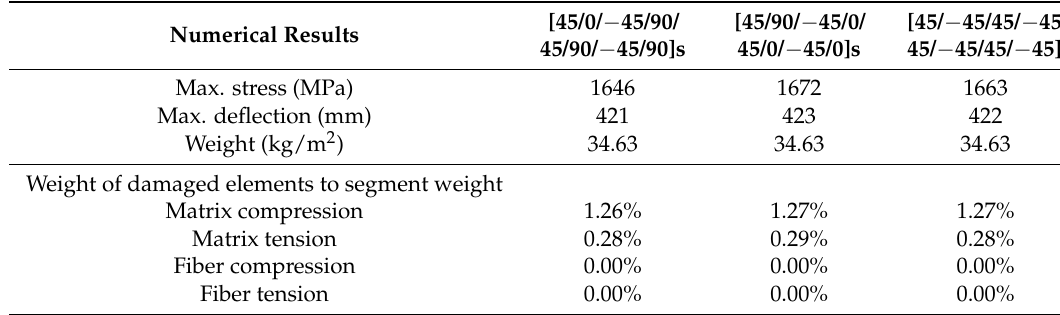
Table 5. Parameter study for the laminate layups of the outer